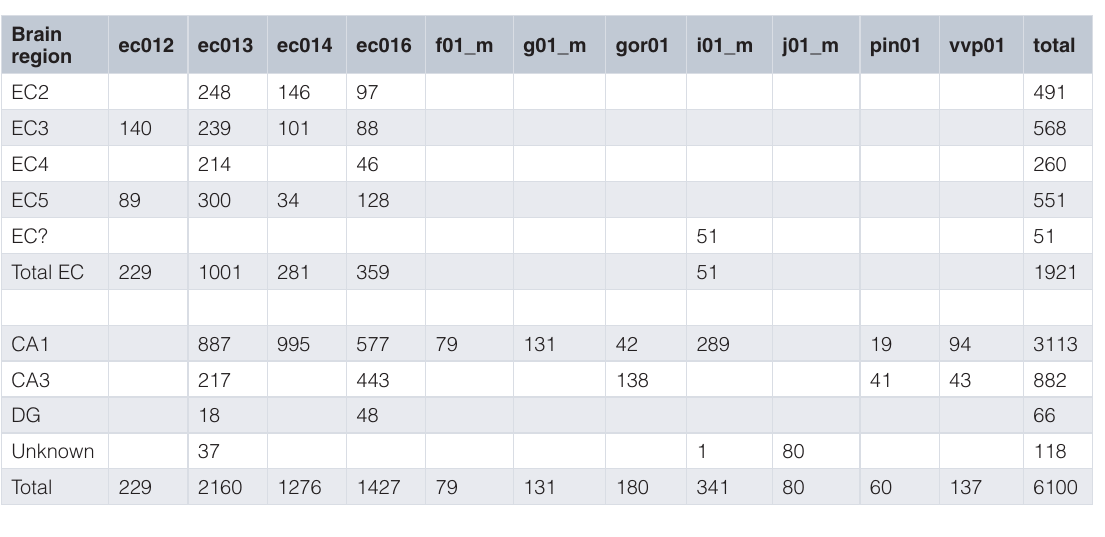
Table 4. Number of interneurons. Top row: animal identifier. Left column: brain region. Brain